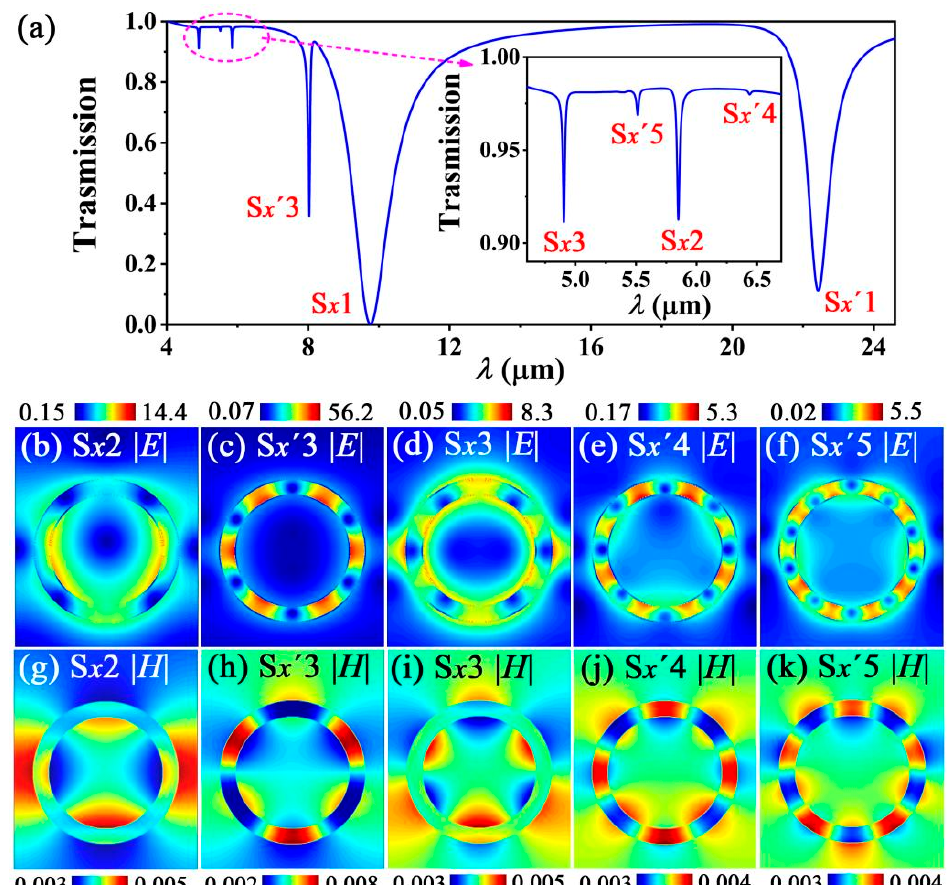
Figure 8. ( a ) Simulated transmission spectra for low and high-order modes. The insert shows the transmission spectra of the region surrounded by the pink short dash line. ( b – f ) show the | E | dis- tribution of the S x 2, S x ′ 3, S x 3, S x ′ 4, and S x ′ 5 modes, respectively. ( g – k ) show the | H | distribution of the S x 2, S x ′ 3, S x 3, S x ′ 4, and S x ′ 5 modes, respectively.